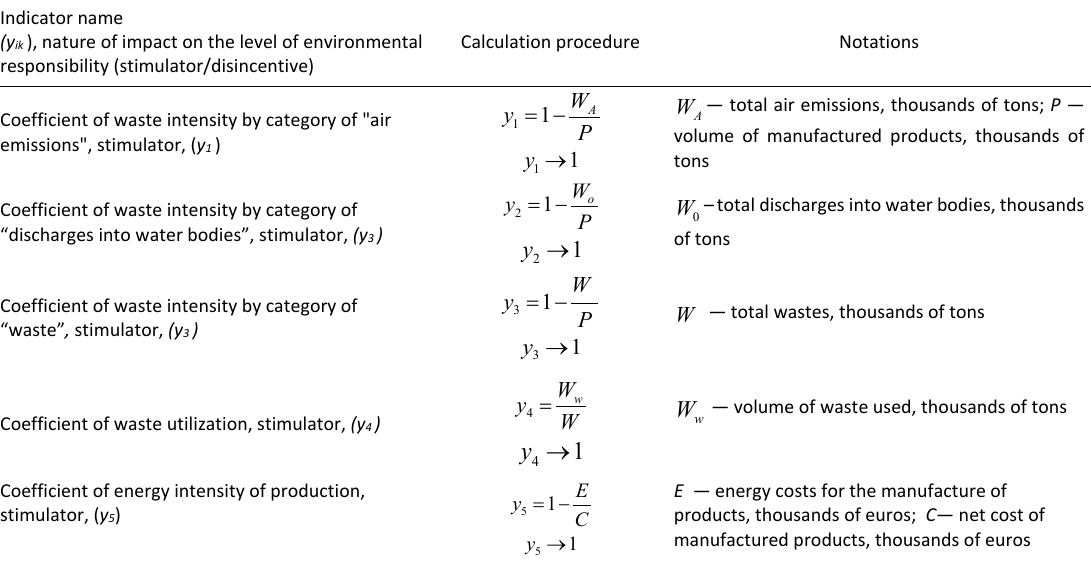
Table 2: Indicators for assessing the level of environmental responsibility of industrial enterprises — block of environmental commitment